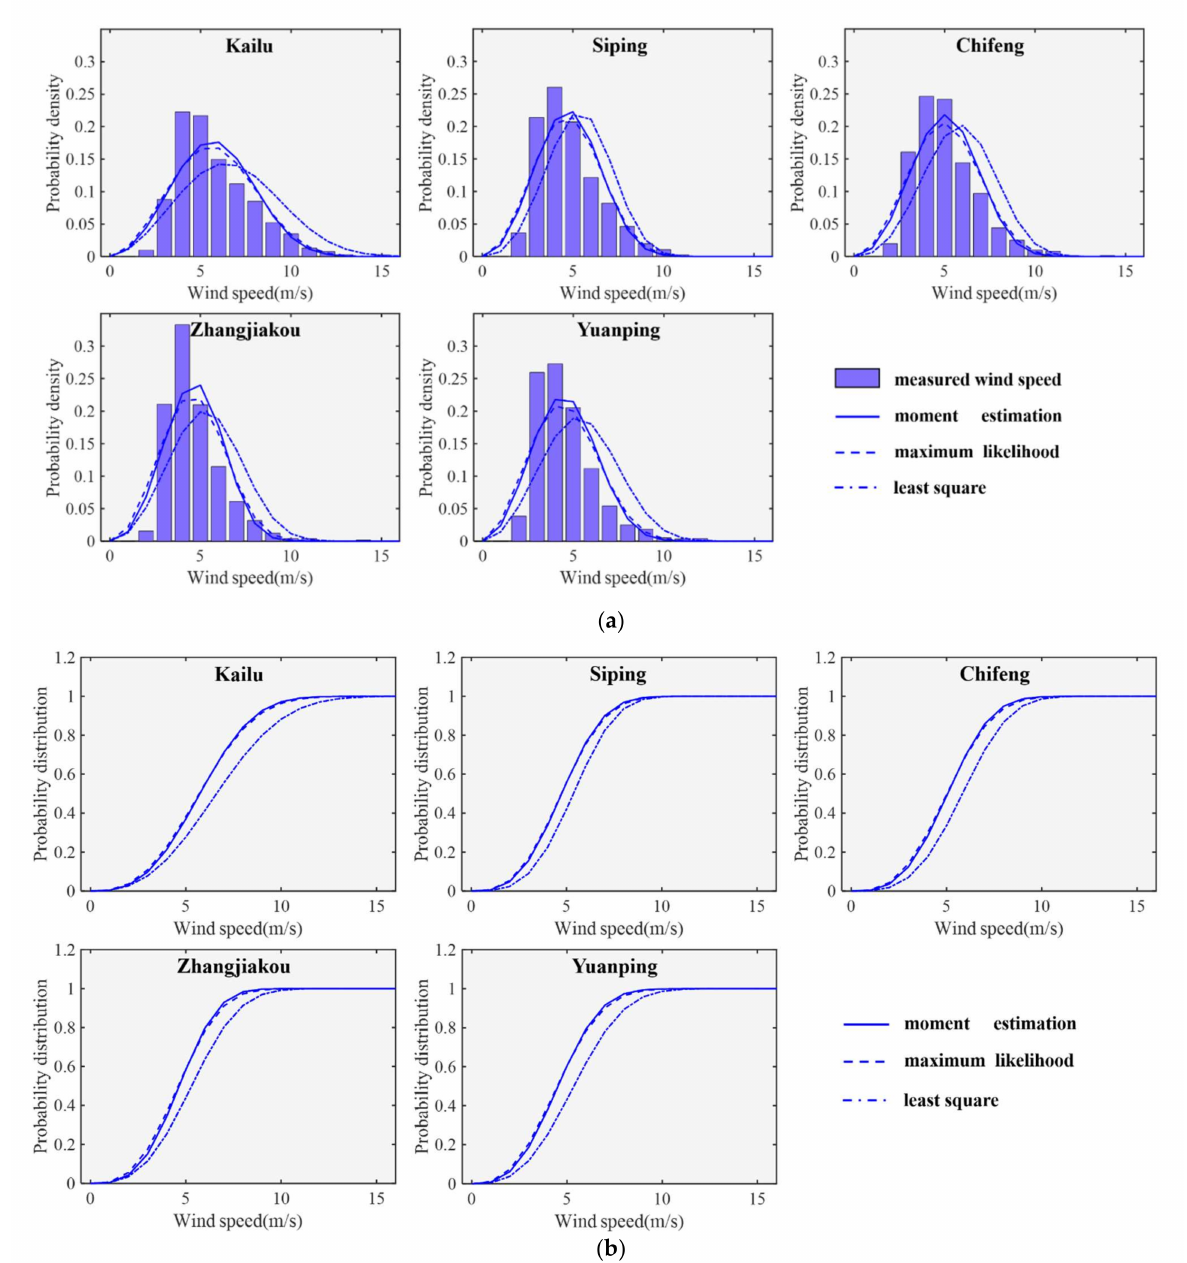
Figure 4. Probability density and probability distribution diagram of daily maximum wind speed. ( a ) Probability density and ( b ) probability distribution. Table 1. Accuracy evaluation of probability density and probability distribution for daily maximum wind speed.